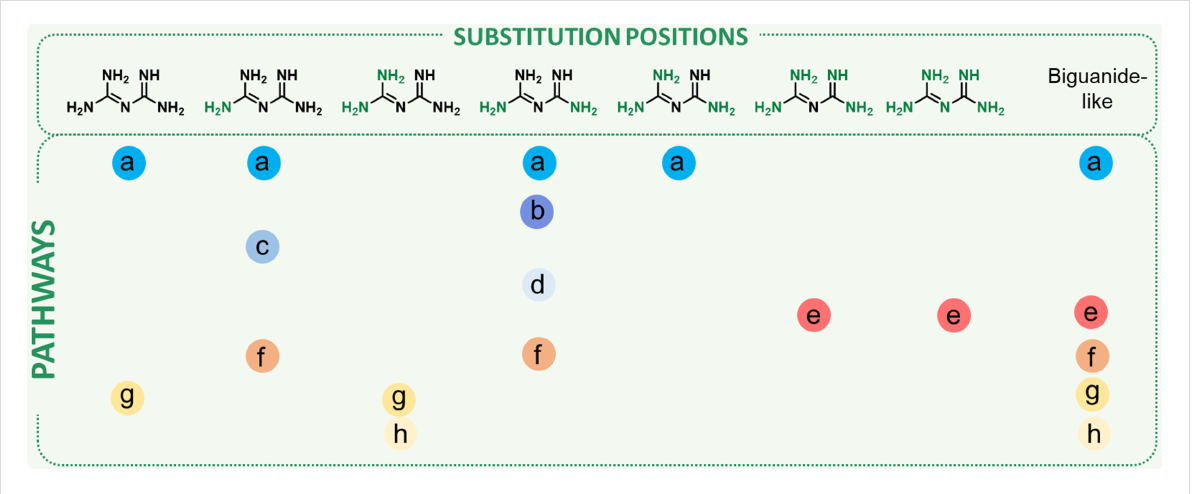
Figure 4: Substitution pattern of biguanides accessible by synthetic pathways